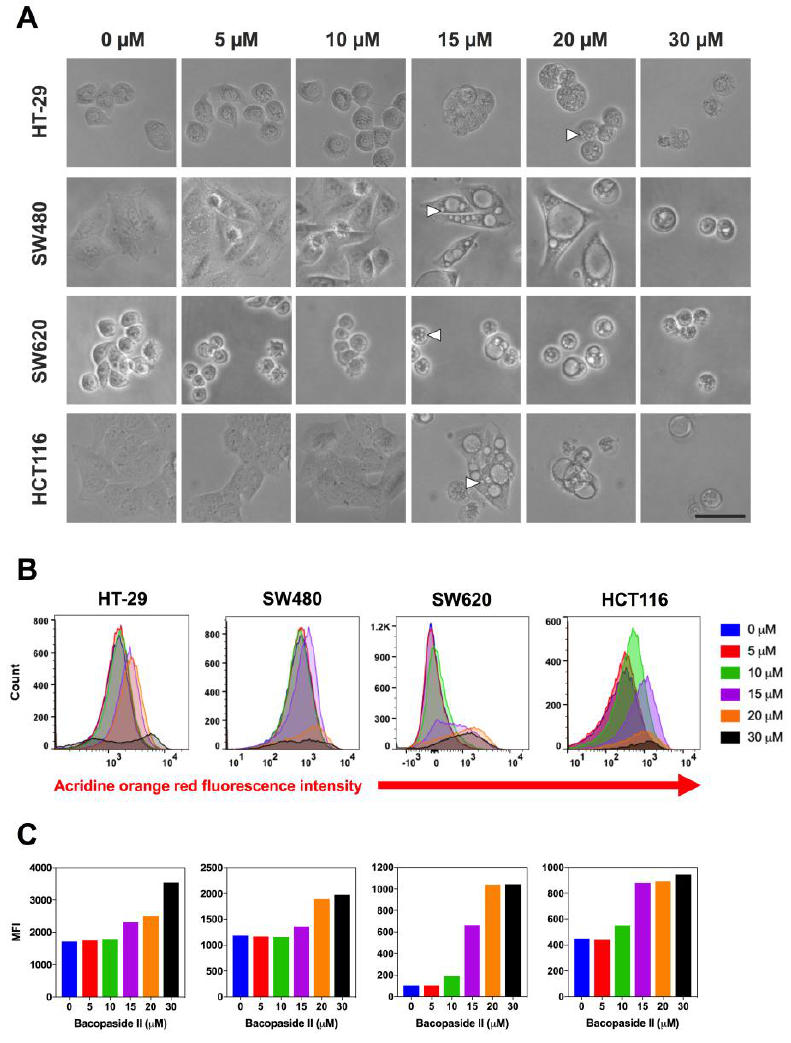
Figure 3. ( A ) Effect of bacopaside II on colon cancer cell morphology. Cells were treated for 48 h with various doses of bacopaside II. Intracellular vacuoles (white arrows) were prominent in HT-29 at 20 µ M and in SW480, SW620 and HCT116 at 15 µ M. Magnification 200 x, scale bar = 25 µ m. ( B ) Effect of bacopaside II on acridine orange staining. Cells were treated with bacopaside II for 24 h, stained with acridine orange, and red fluorescence intensity was analysed by flow cytometry showing representative histograms of the red fluorescence intensity. ( C ) Red mean fluorescence intensity (MFI) values derived from the